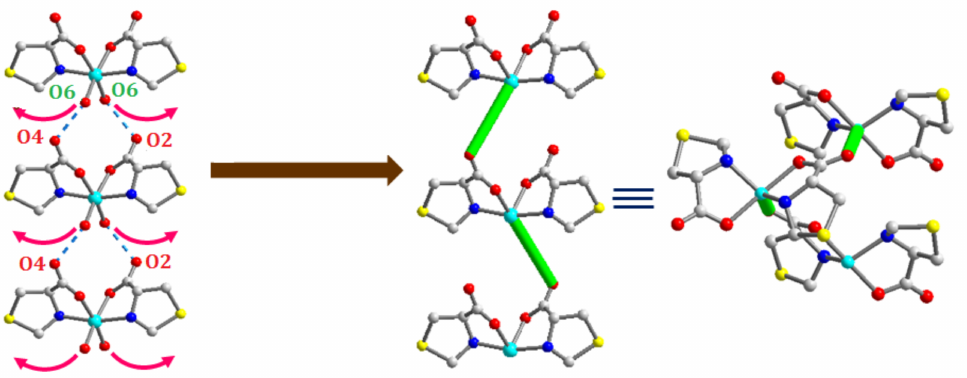
Figure 6. A plausible mechanism for compound 1 underwent a structural transformation. Upon the removal of labile water (O6), creating the activation sites on the Zn(II) centers and the neighbouring carboxylate oxygen atoms (O2, O4) form the tpro − ligands were also activated and distorted to a suitable orientation, so that they were facilely attacked to the Zn(II) centers in the solid